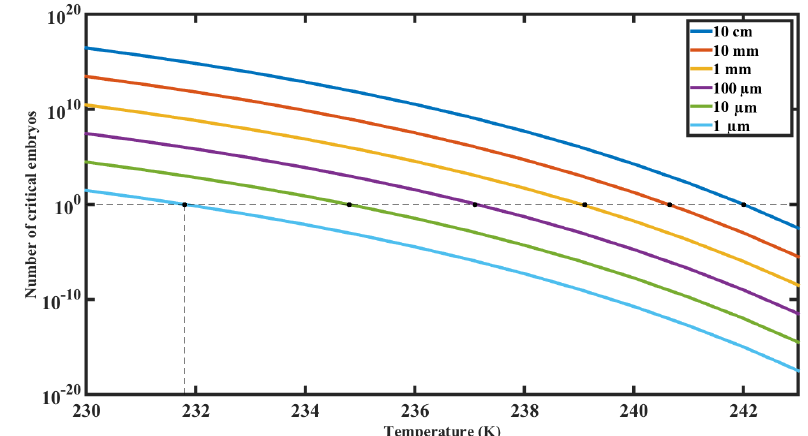
Figure 2. Mean number of critical embryos N c_mean (by Eq. 1) in a pure water droplet ( a w = 1) with different size (diameter) as a function (V,a w ) derived by Eq. (2) (using σ i / w , e from the TIP4P of temperature. Solid circle: the approximations T N c = 1